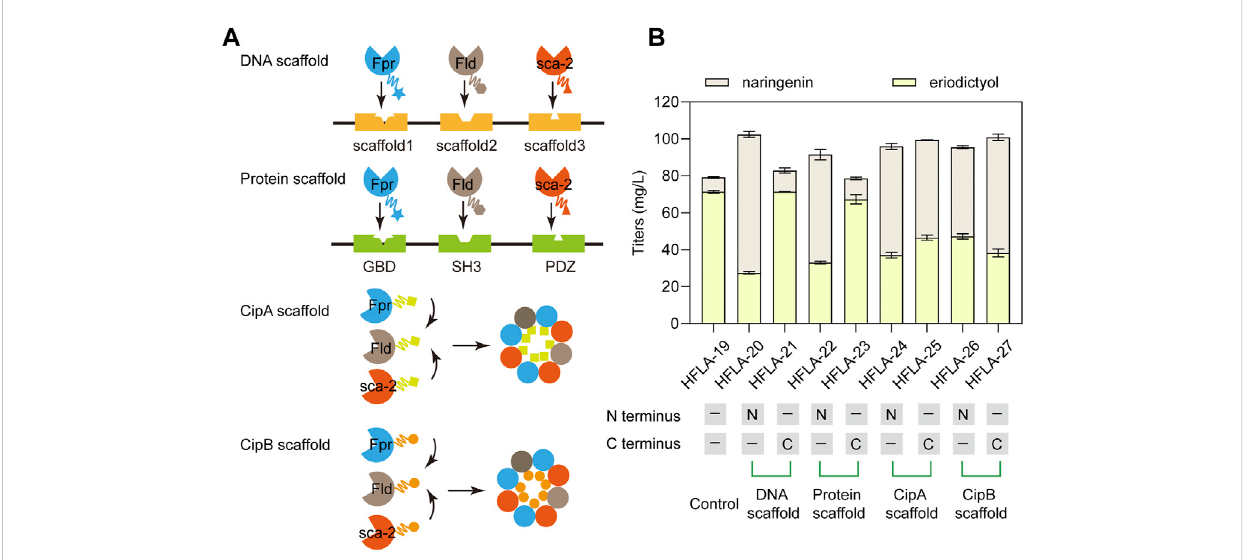
Improvementoftheelectrontransfer ef fi ciency bydifferentscaffolds. (A) Schematicrepresentation oftheassembly ofP450s and redox partners by the DNA scaffolds, Protein scaffolds, CipA scaffold, and CipB scaffold, respectively. (B) Titers of eriodictyol produced by different sca-2 mut